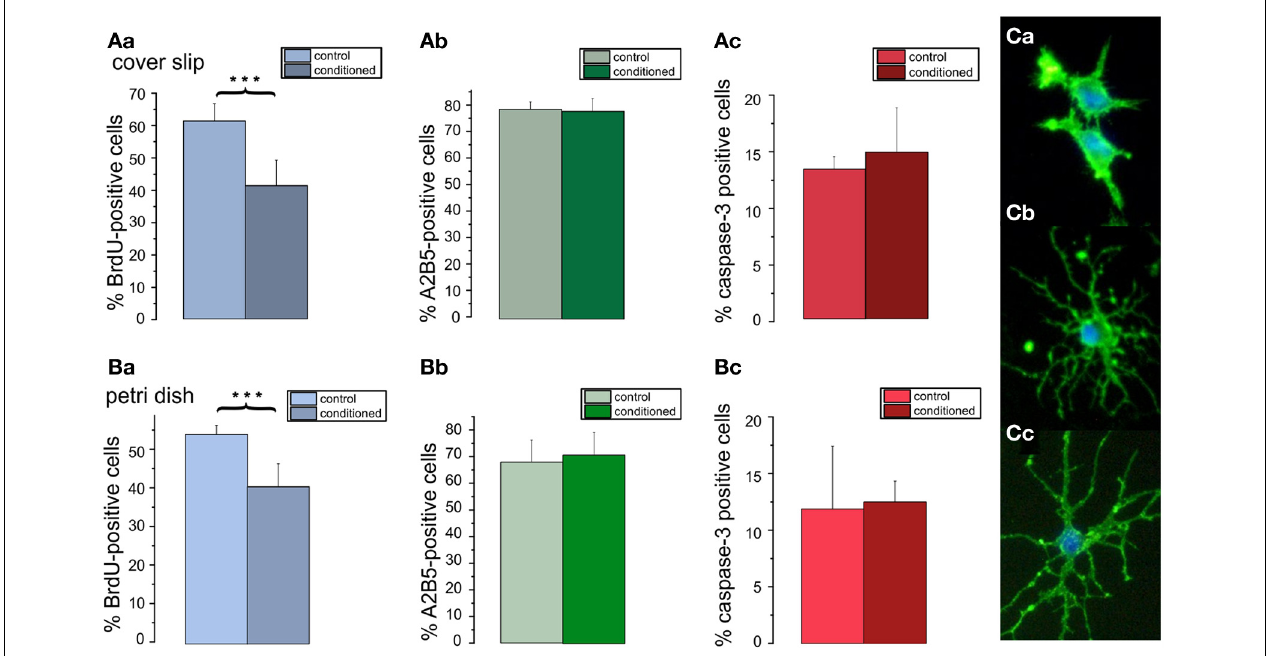
FIGURE 7 | Effects of conditioned media on percentage of A2B5 positive cells, proliferation, and apoptosis in low density cultures. Cells plated with a seeding density of 5000 cells/coverslip cultured in DMEM based proliferation medium for 3 days (control) or in parallel with the supernatant of high density cultures (80000 cells/coverslip) (conditioned). Bar graphs shown in (A) represent results of immunostainings for (Aa) BrdU, (Ab) A2B5 (Ac) caspase-3 performed